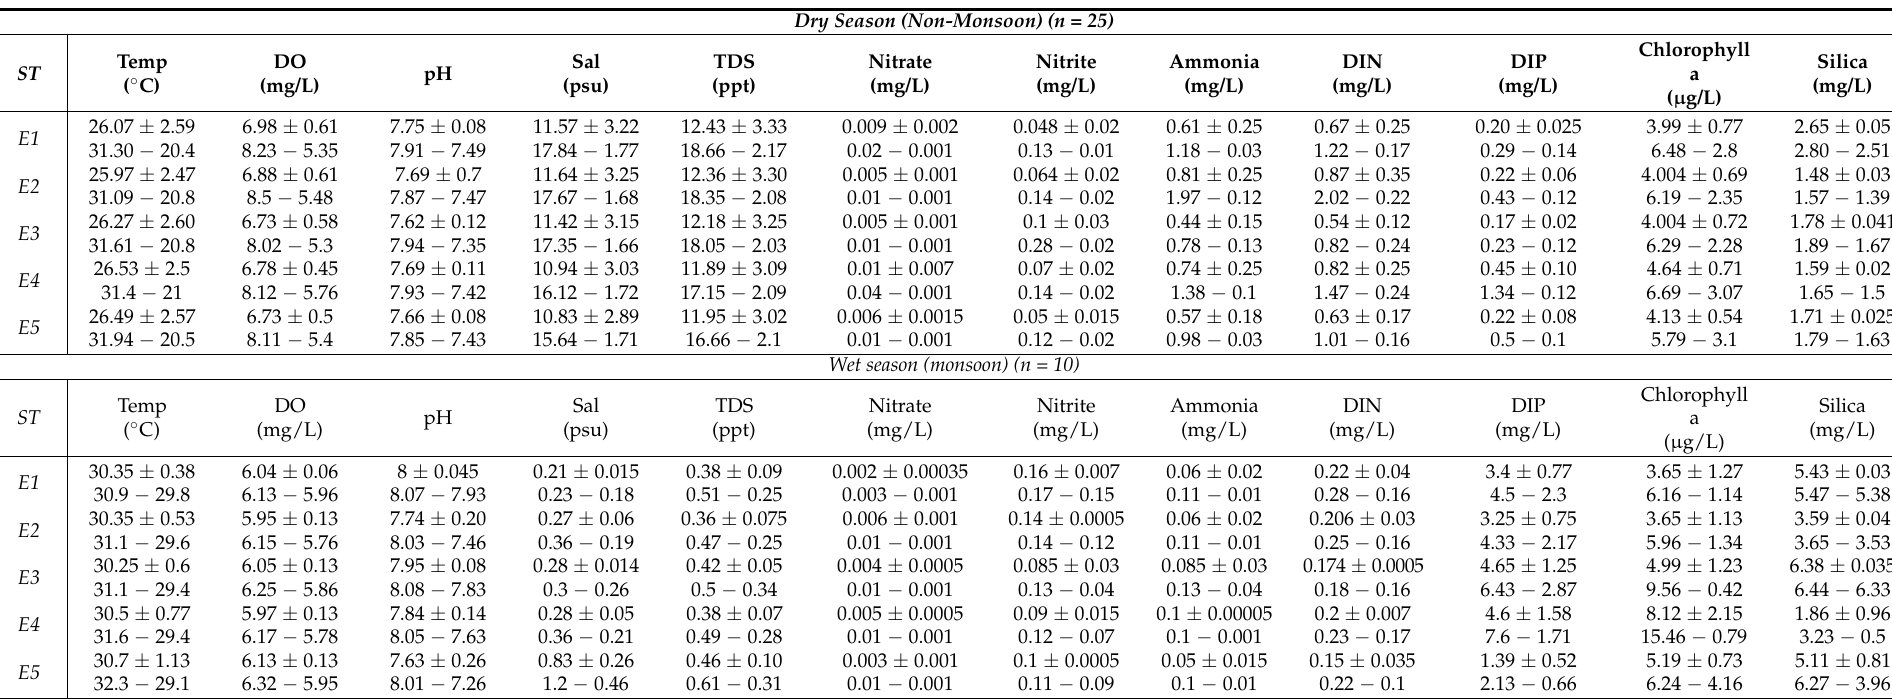
Table 2. Average, standard error, maximum, and minimum values of different environmental and chlorophyll a parameter distribution in the